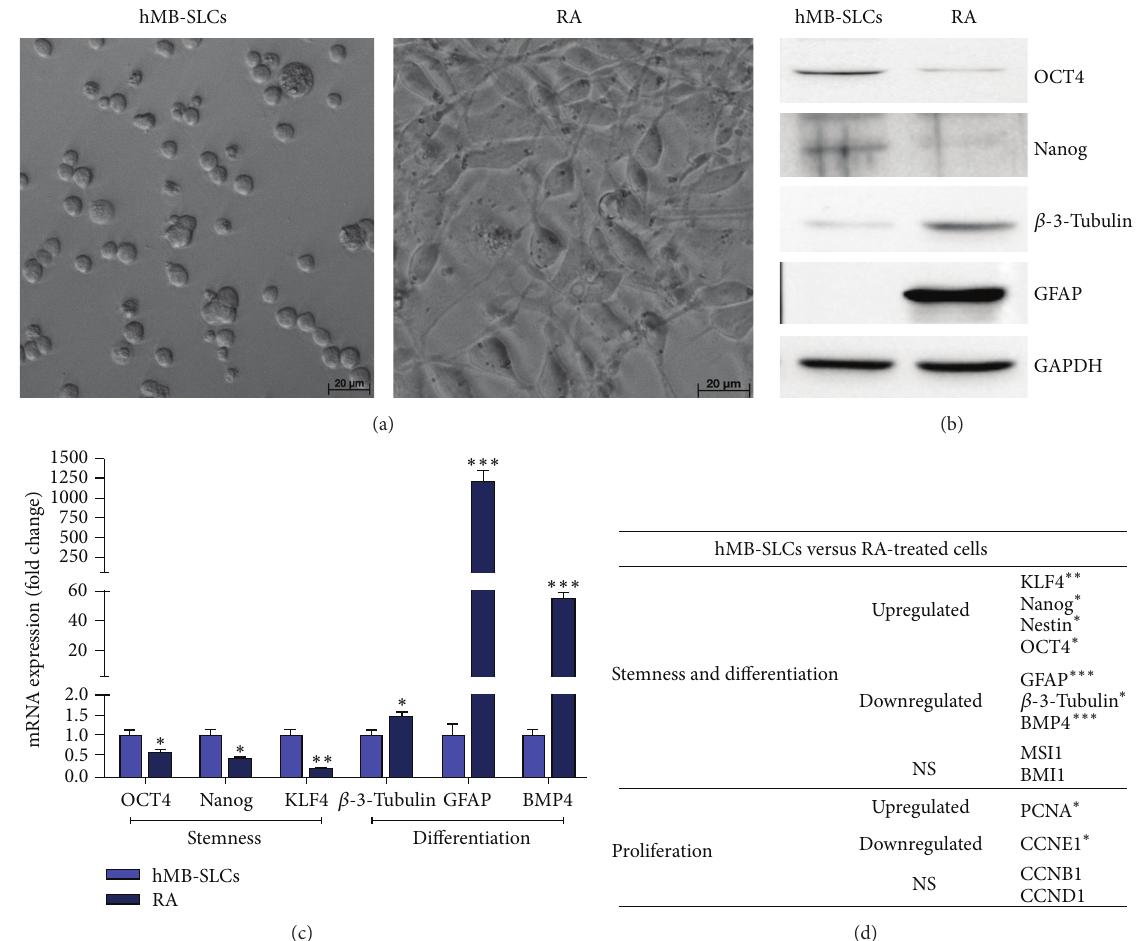
Figure 2: Morphology and characteristics of hMB-SLCs. (a) hMB-SLCs were cultured for 48 h in the absence or in the presence of 8 𝜇 M RA which induces SLCs differentiation, highlighted by morphological changes and cell adhesion. (b) Western blot analysis confirmed that 48 h exposure of hMB-SLCs to 8 𝜇 M RA induced a strong reduction in the stemness markers Nanog and OCT4 while increasing the differentiation markers, 𝛽 -3-Tubulin and GFAP. (c) qPCR analysis of OCT4 , Nanog , KLF4 , 𝛽 -3-Tubulin , GFAP, and BMP4 was conducted before and after RA treatment. mRNA expression levels are indicated as fold changes with respect to hMB-SLCs. (d) Gene expression of stemness, differentiation, and proliferation markers in hMB-SLCs with respect to RA-treated cells. ∗ denotes 𝑝 < 0.05 versus hMB-SLCs, ∗∗ denotes 𝑝 < 0.01 versus